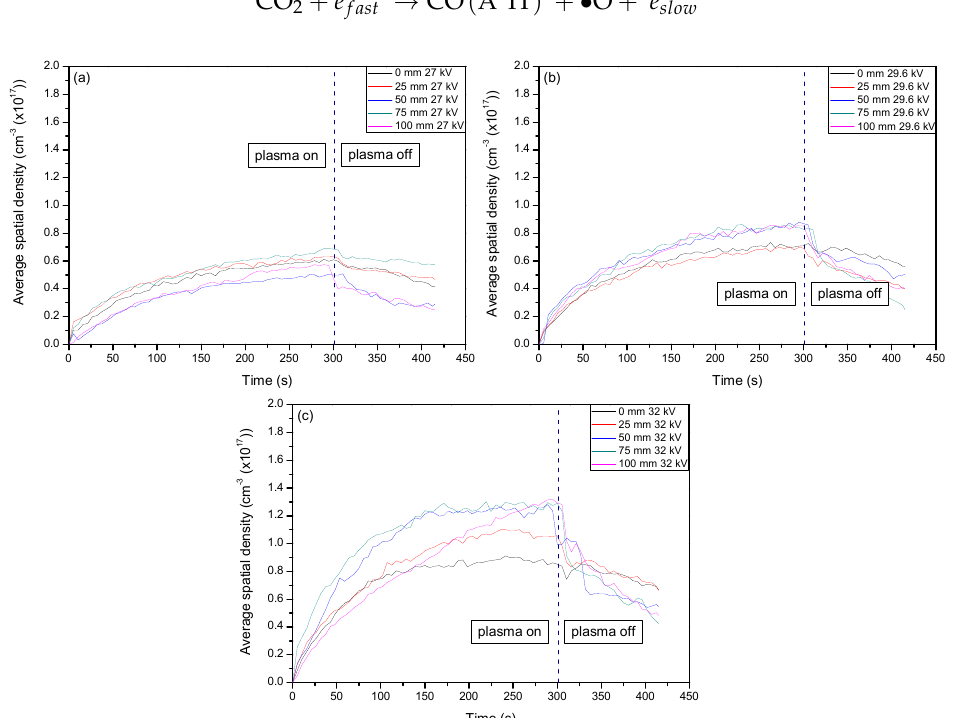
Figure 1. Average spatial density profile of O 3 at 253.7 nm when ambient air was the only gas present for plasma discharge. The line divides values at the point when the plasma system was set to stop generating plasma. ( a – c ) show the changes of O 3 average spatial density with respect to voltage.